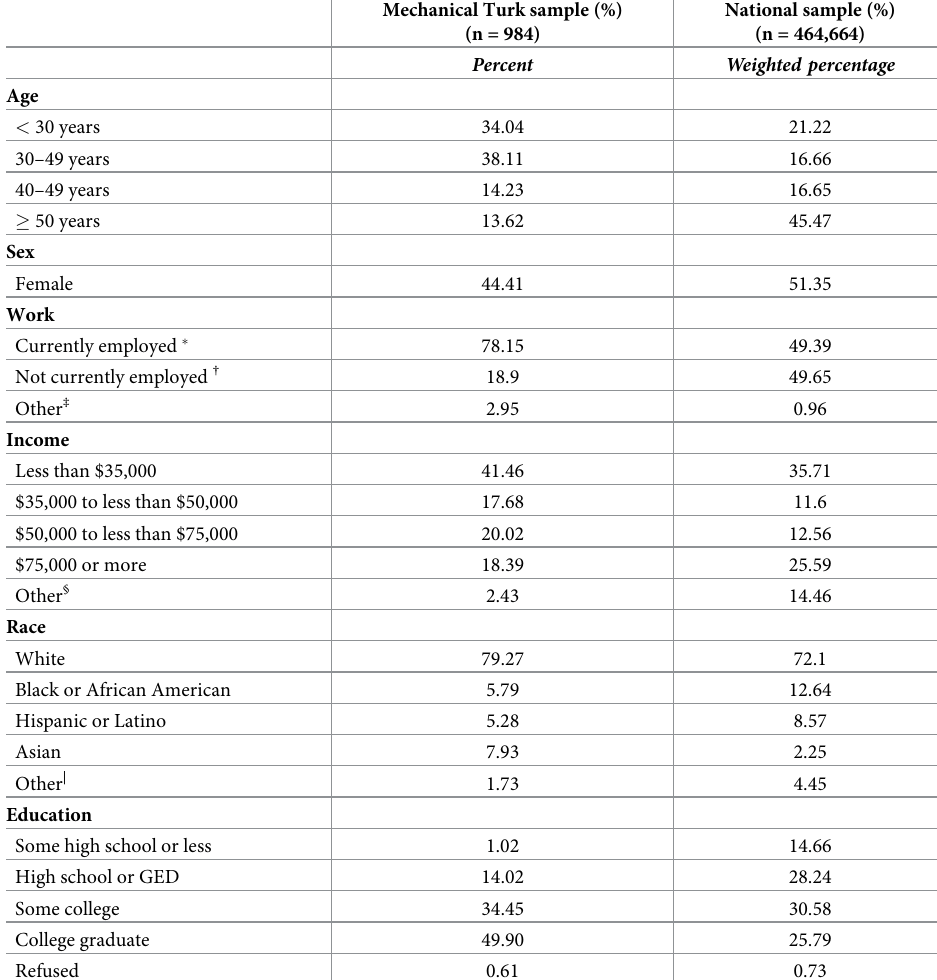
Table 1. Characteristics of Mechanical Turk workers versus national 2014 BRFSS